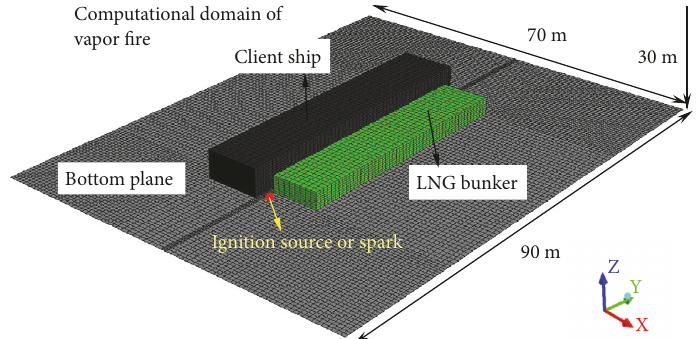
Figure 5: Computational domain of LNG vapour